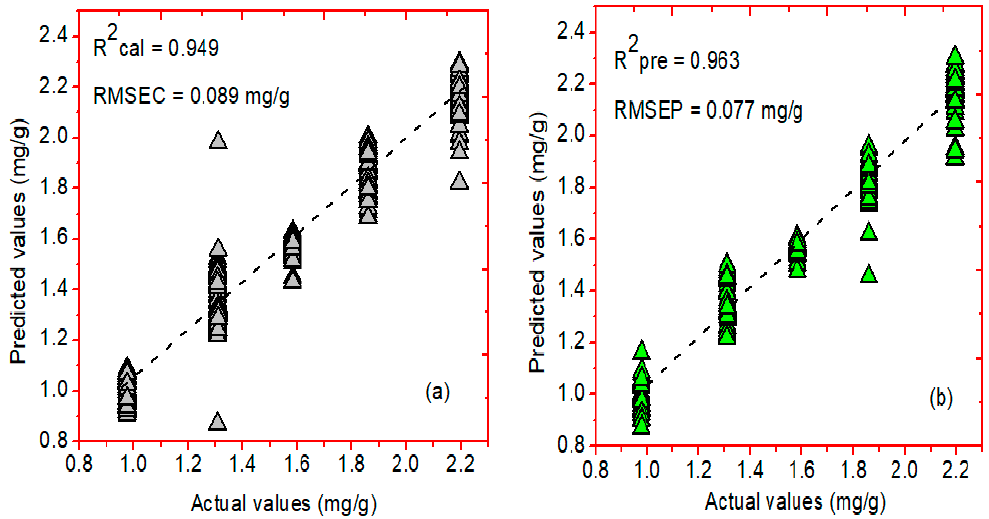
Figure 9 . PCR graphs of actual and predicted concentration values for the phenolic compounds in Arabidopsis powder samples using ( a ) calibration and ( b ) prediction datasets, respectively.